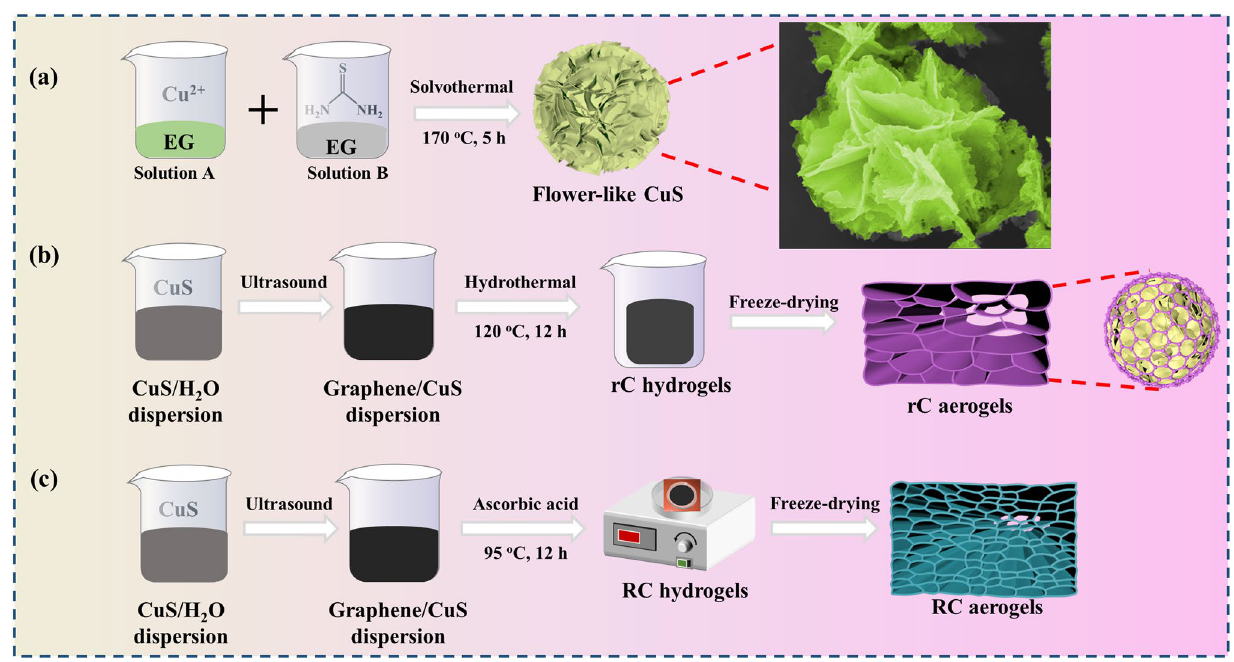
Fig. 1 Schematic diagram of preparation processes of a flower-like CuS microspheres, and b, c CuS@rGO composite aerogels through a hydro- thermal method ( b ), and via the ascorbic acid thermal reduction ( c